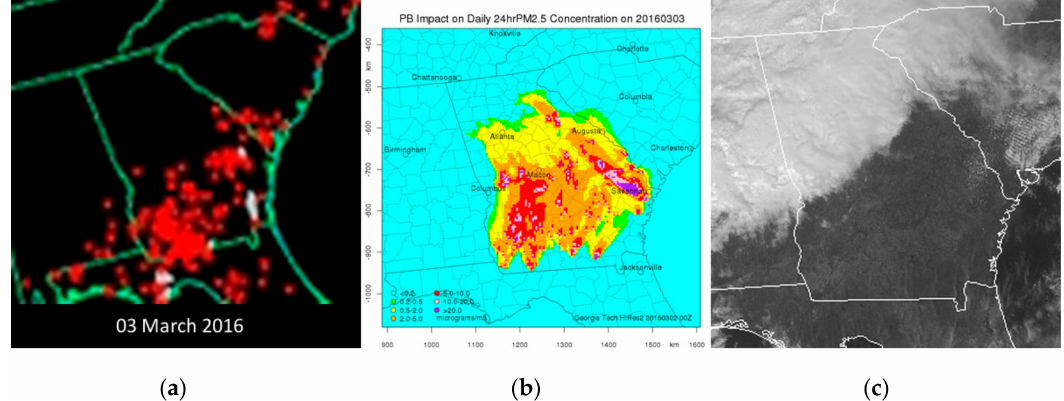
Figure 3. ( a ) NOAA’s Hazard Mapping System Fire and Smoke Analysis; ( b ) forecast of burn impacts on PM 2.5 levels; and ( c ) cloud cover for 3 March 2016. The largest impacts on PM 2.5 (shown in purple) can be used as a proxy for burn